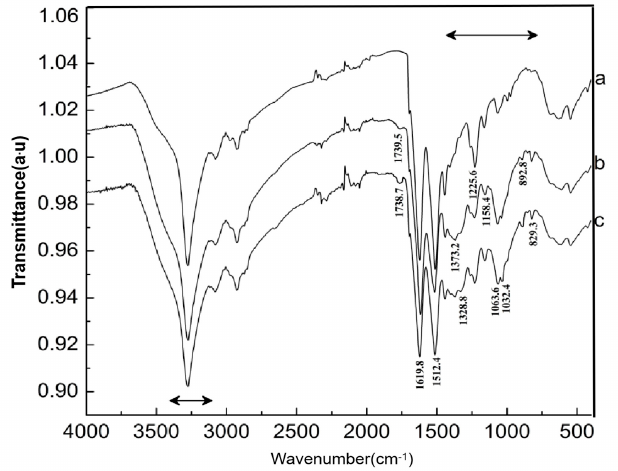
Figure 8. The infrared spectrum of cashmere fiber before and after carboxylic chitosan modification: ( a ) untreated cashmere fiber; ( b ) cashmere fiber with graft add-on of 4.34% chitosan; and ( c ) cashmere fiber with graft add-on of 9.51% chitosan).